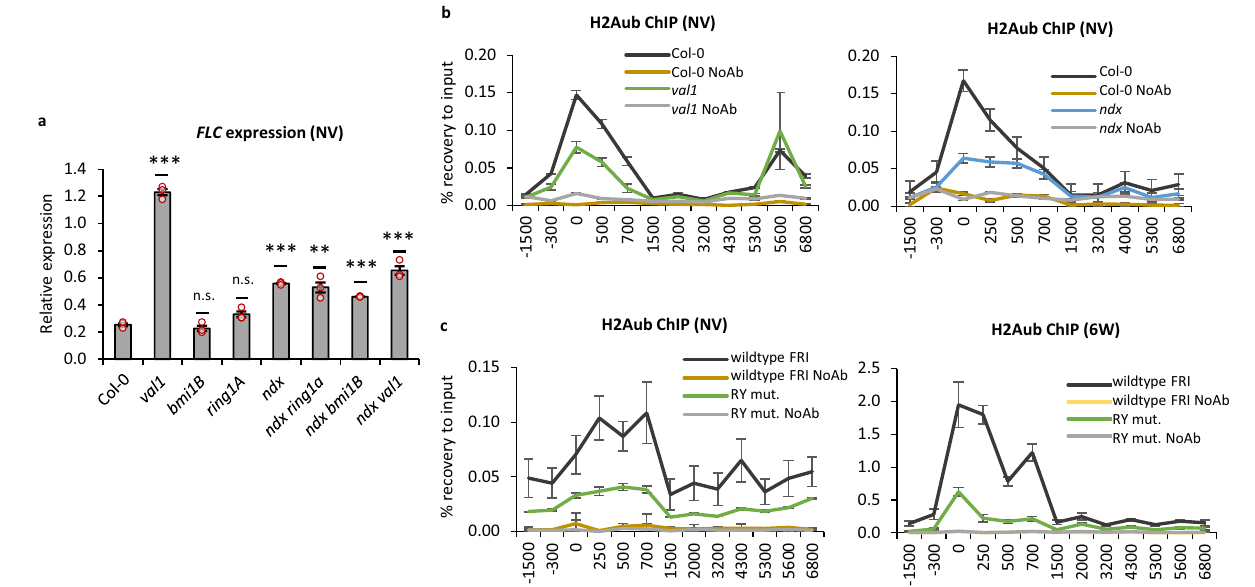
Fig. 6 | VAL1, PRC1, and NDX are required for H2Aub accumulation at the FLC nucleation region. FLC expression and H2Aub enrichment depend on VAL1, NDX, and PRC1. a FLC expression in mutants of VAL1,PRC1,and NDX. Values correspond to the mean relative expression to the geometric meanof UBC and PP2A . Statistics are calculated with a two-tail Student ’ s t -test in comparison to Col-0. N =3